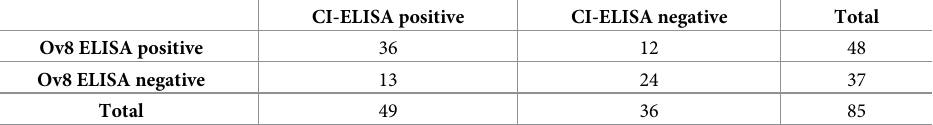
Table 3. Antibody detection by Ov8 ELISA and MCFV CI-ELISA in 85 serum samples from bison with clinical MCF confirmed by PCR. CI-ELISA positive CI-ELISA negative Total Ov8 ELISA